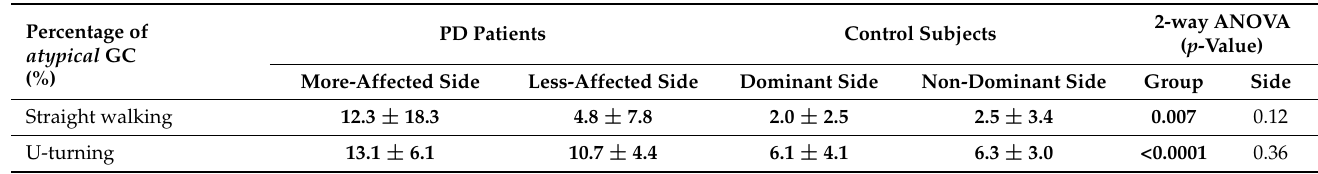
Table 2. Percentage of atypical gait cycles in straight path and U-turns in PD patients and control